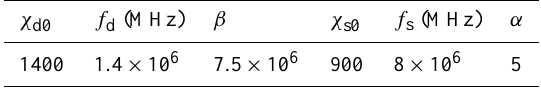
Table 1. Susceptibility dispersion parameters for spin and domain wall resonance of Ferroxcube 3C95 Mn–Zn ferrite.